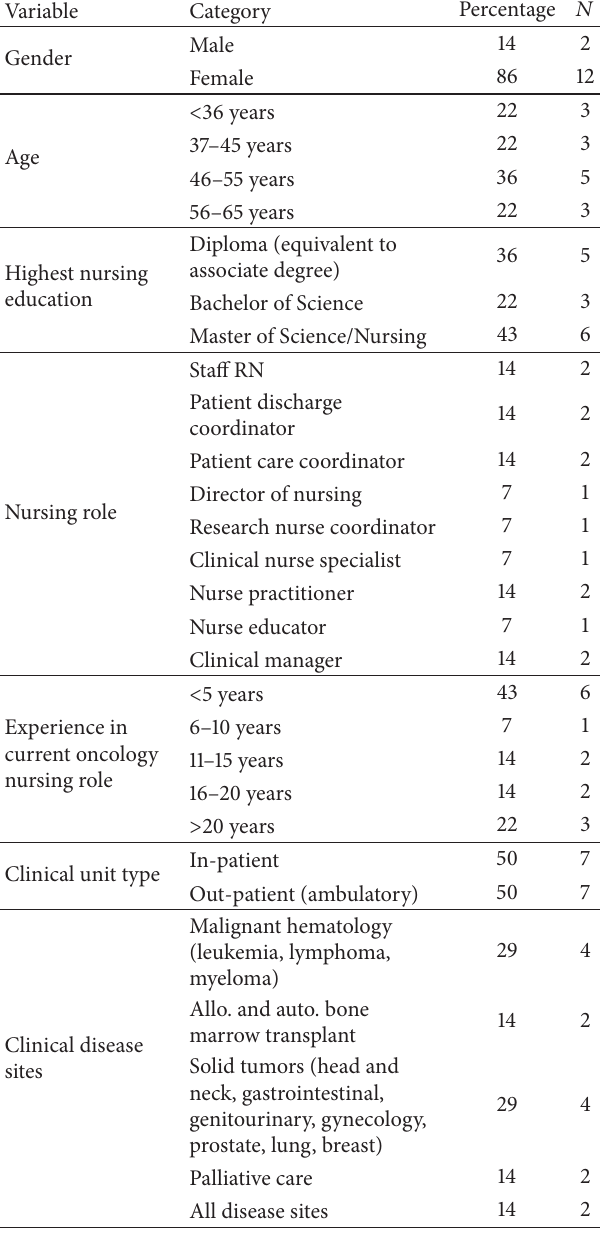
Table 1: Participant demographics ( 𝑛 = 14